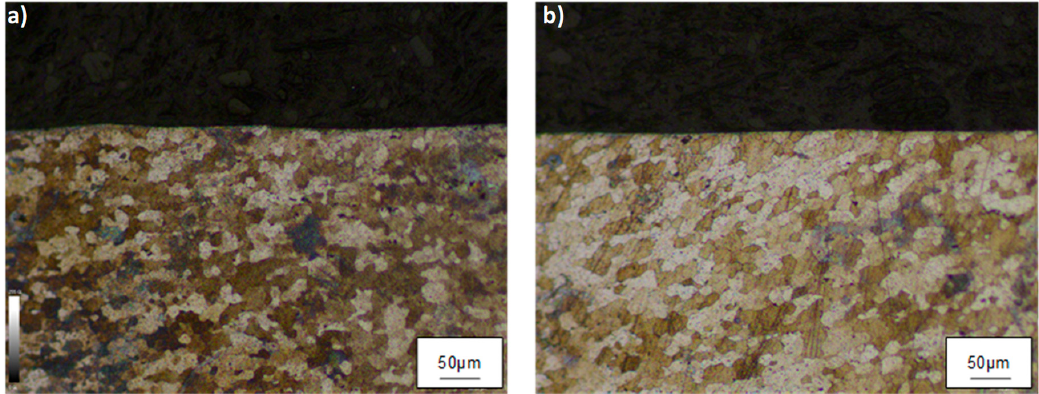
Figure 18. Microstructure 20 × . ( a ) After burnishing operation (P = 10 MPa); ( b ) after burnishing operation (P = 30